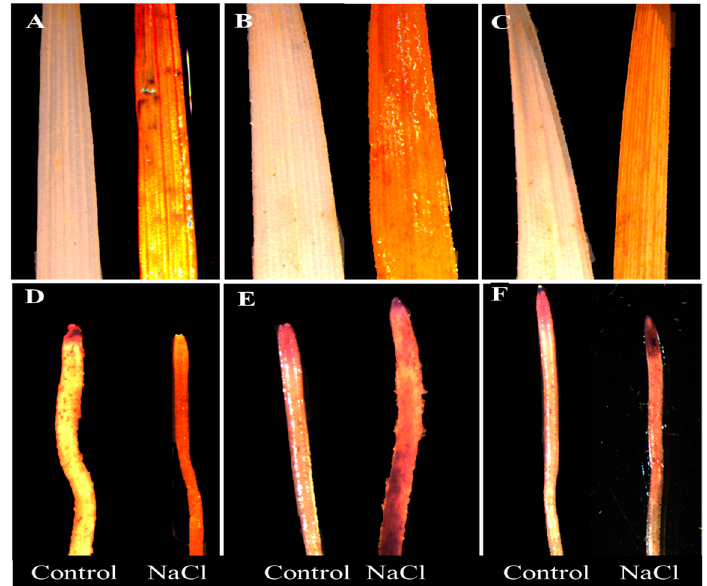
Figure 3. Histochemical detection of H 2 O 2 by DAB (3,3-diaminobenzidine) staining in leaves (top row) and roots (bottom row) of two wheat cultivars—Suntop ( A , D ), Sunmate ( B , E )—and barley cultivar CM72 ( C , F ). The samples were collected after 7 days of 100 mM NaCl treatment.